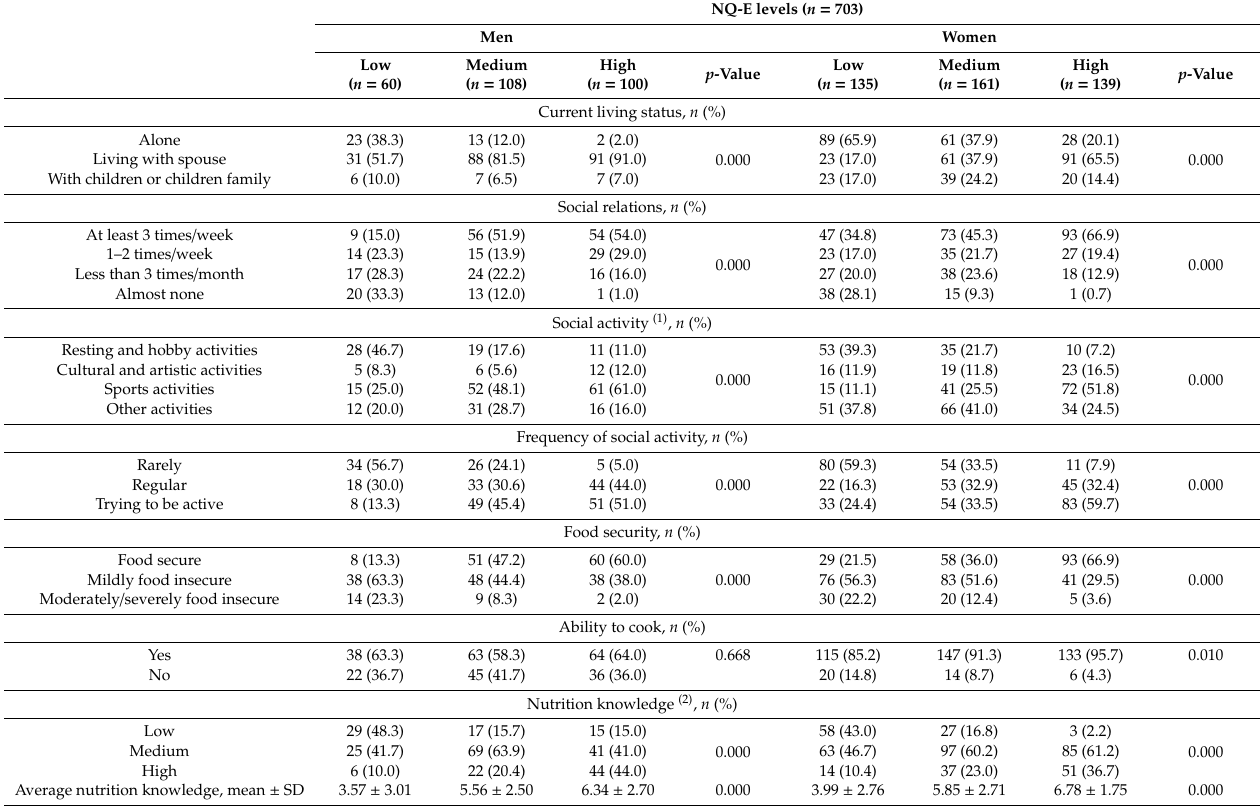
Table 4. Living environmental factors of the subjects according to NQ-E